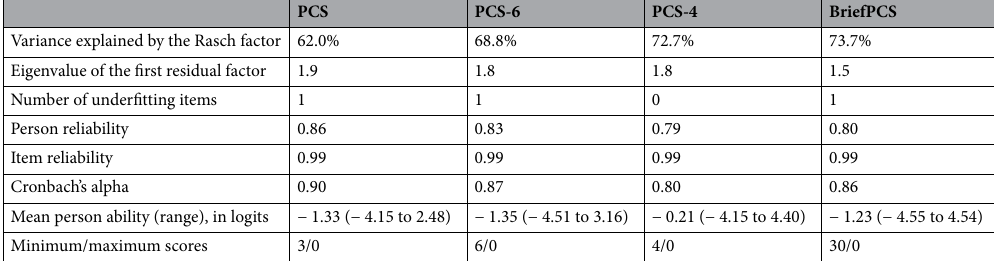
Table 2. Main results of Rasch analysis of the four PCS versions, regarding: unidimensionality analysis (principal component analysis of the residuals); number of underfitting items; reliability indices (Rasch person and item reliability, and Cronbach’s alpha); mean and range of person ability estimates; and number of extreme (maximum and minimum) scores.